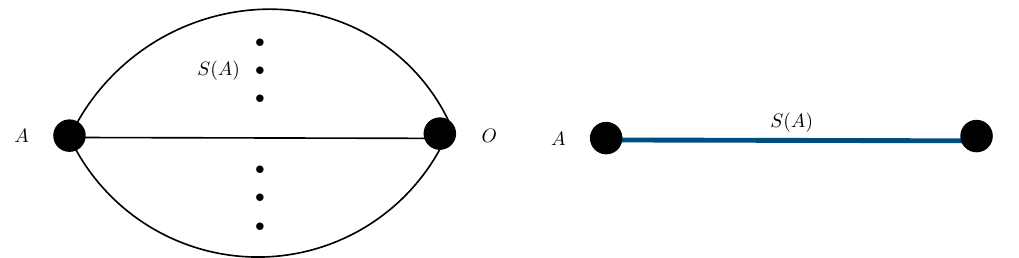
Figure 2 . Given a configuration of bit threads we can course grain or desiccate the geometry keeping only the geometry which the threads pass. This is essentially a collection of S between the boundary regions A and O . In this way each bit thread can be viewed as a distilled Bell pair realizing